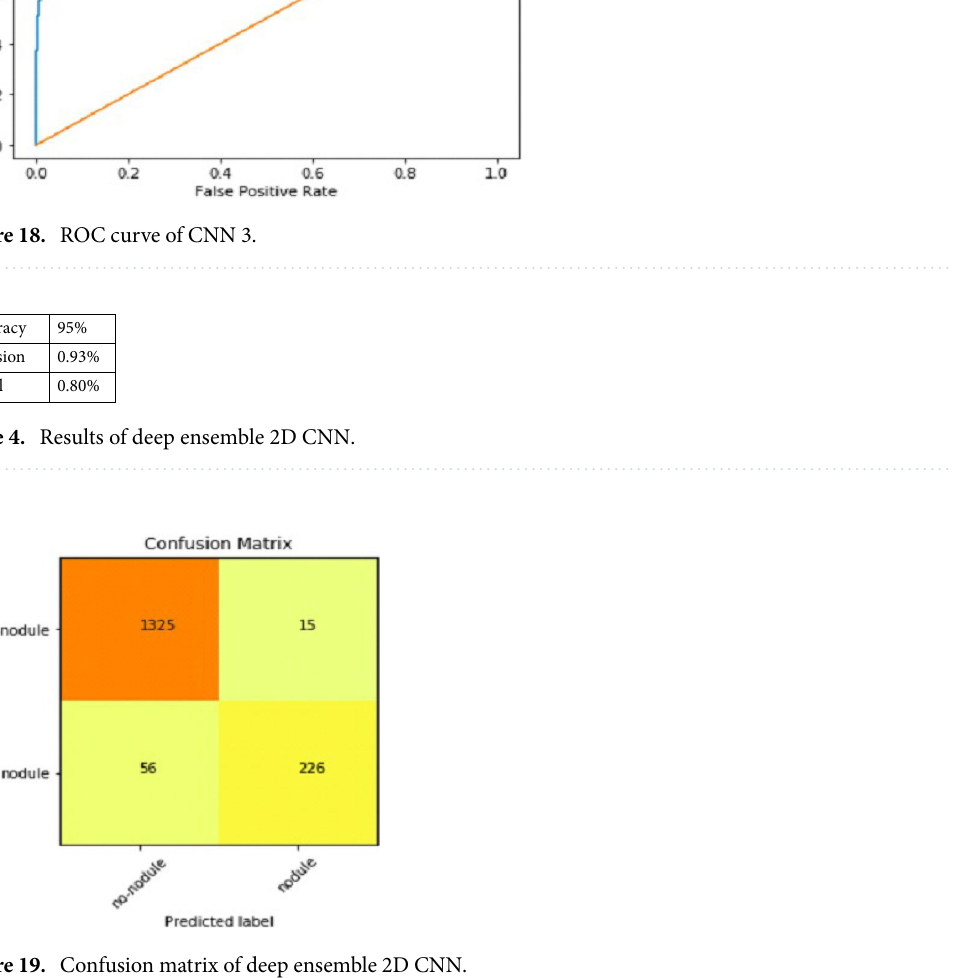
Figure 19. Confusion matrix of deep ensemble 2D